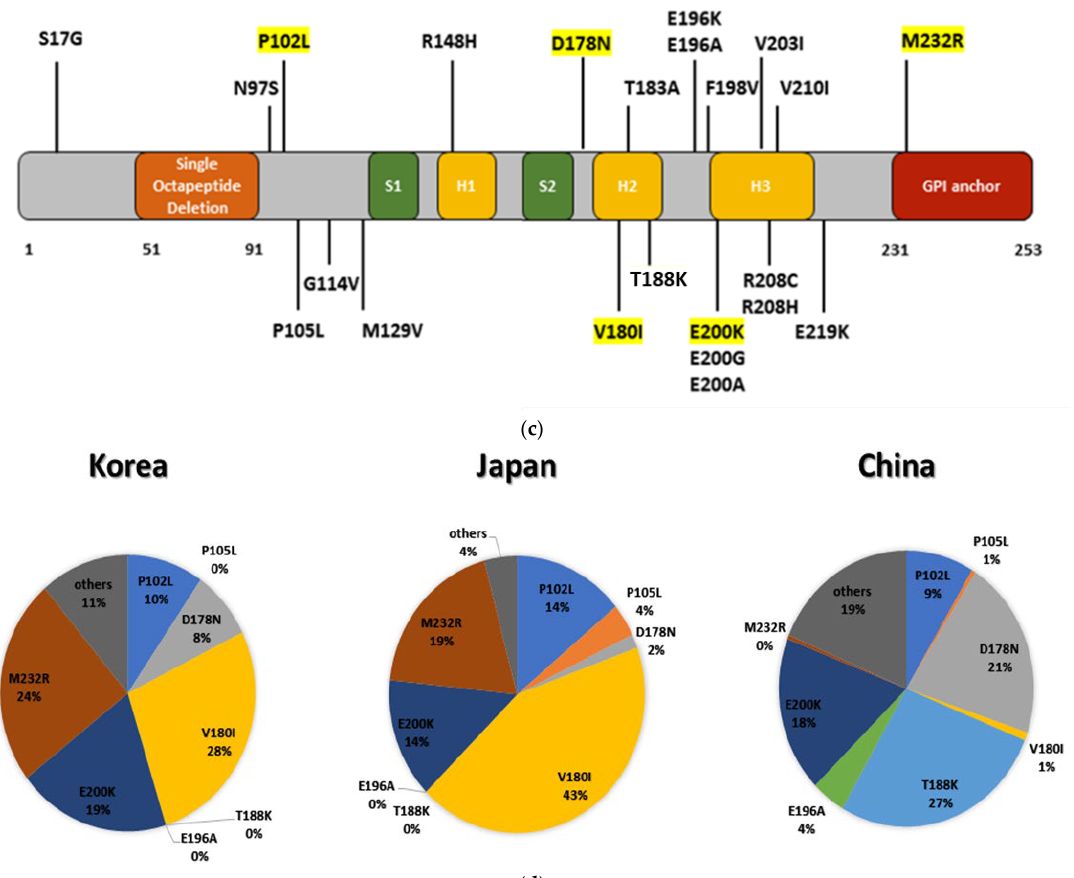
Figure 2. Mutations, reported in ( a ) Korean patients ( b ) Japanese patients ( c ) Chinese patients. Highlight mutations were mutually reported prion variants in Korea, Japan, and China. ( d ) Most commonly occurring mutations prion mutations in Korea, China, and Japan.